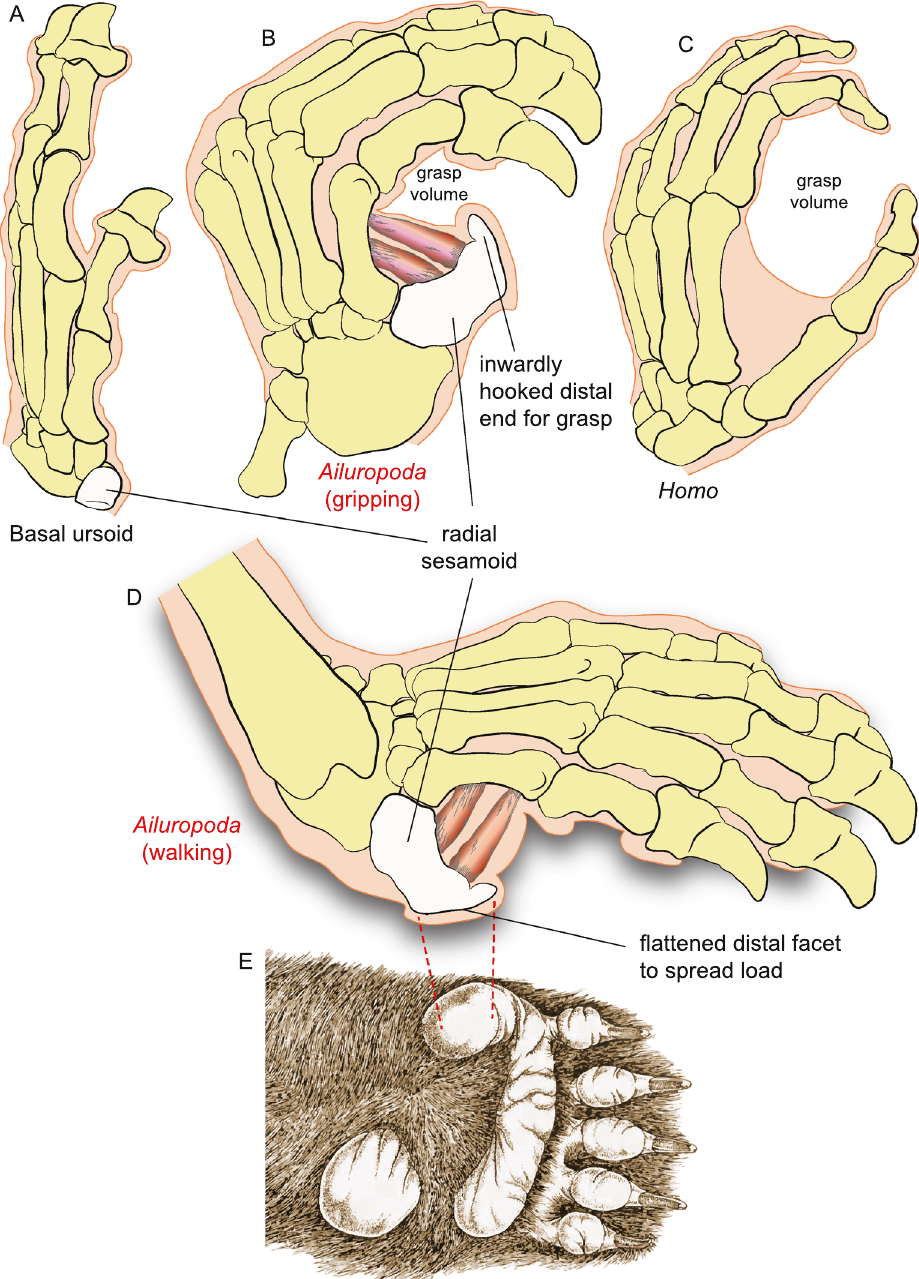
Figure 5. Comparison of the radial sesamoid in the basal ursoid, Ailuropoda , and Homo and the positioning of the radial sesamoid. Illustrations are of left hands. ( A ) A basal ursoid from the early Oligocene of North Dakota (USNM 637,259) showing the primitive condition of an unenlarged radial sesamoid; ( B ) grasping hand in extant Ailuropoda ; ( C ) grasping hand of modern human; ( D ) walking hand of extant Ailuropoda in a plantigrade posture; ( E ) external ventral surface of the hand of Ailuropoda showing a fleshy, plantar pad that corresponds to the radial sesamoid (red dash lines), modified from Davis 8 . Muscles (dark red bundles) between the radial sesamoid and first metacarpal are abductor pollicis brevis and opponens pollicis , following Endo et al. 30 . Note the small distal hook and flat ventral surface of the radial sesamoid in extant Ailuropoda , which are derived features that function for better grasping (small hook) as well as walking (flattened palm surface) in contrast to the primitive conditions seen in Ailurarctos (Fig.